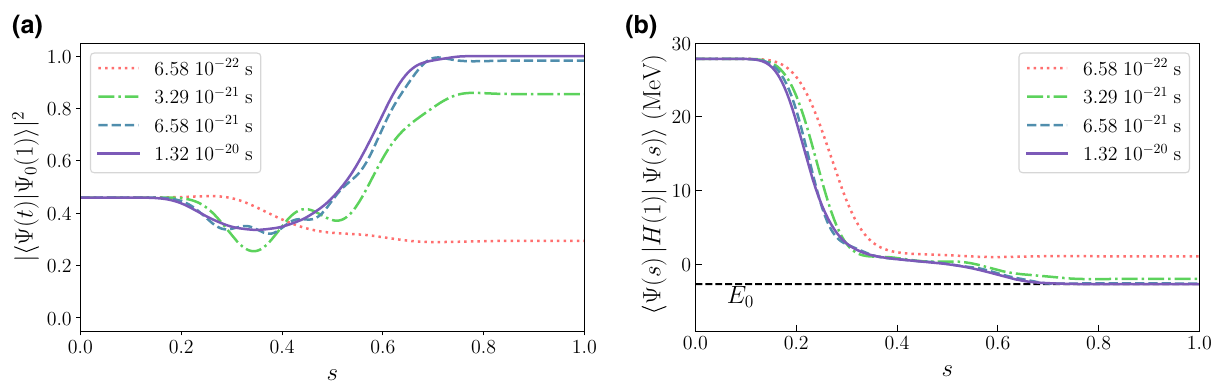
FIG. 6. Adiabatic evolution from a free particle to the interacting system with the S -wave potential of Sec. III. (a) Overlap with the true ground state and expectation of the interacting Hamiltonian as a function of total evolution time. (b) The ground-state energy as a function of total evolution time. The dashed black line marks the physical deuteron binding energy of − 2.2